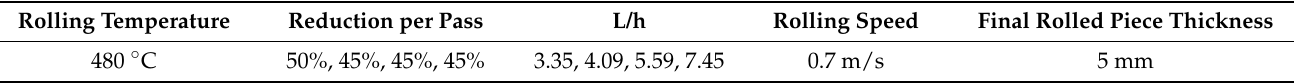
Table 2. Hot rolling process